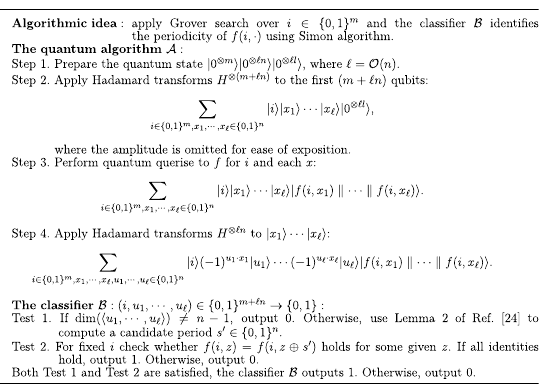
Algorithm 3. Grover-meets-Simon algorithm [24]